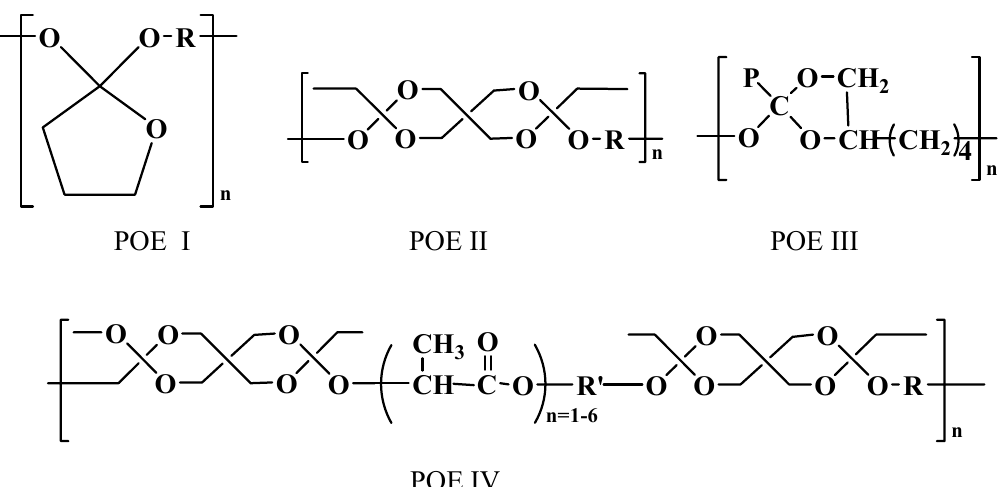
Figure 4. Chemical structures of poly(ortho